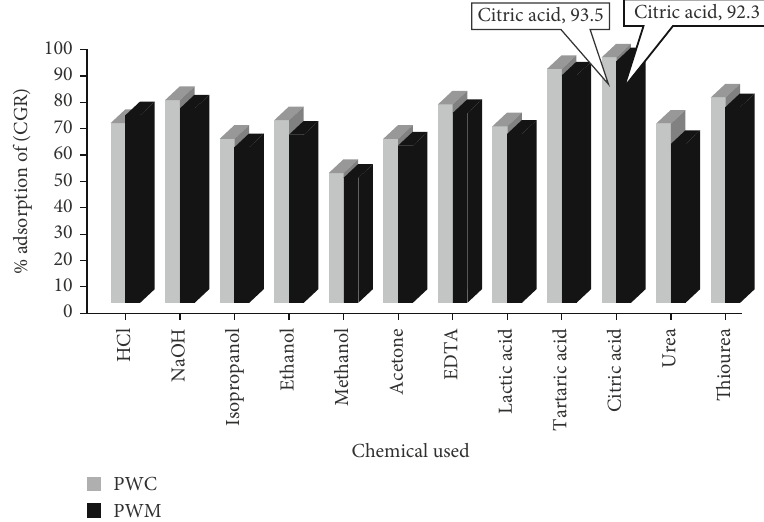
Figure 3: Comparative optimization performance of chemically processed adsorbents with di ff erent modifying agents.